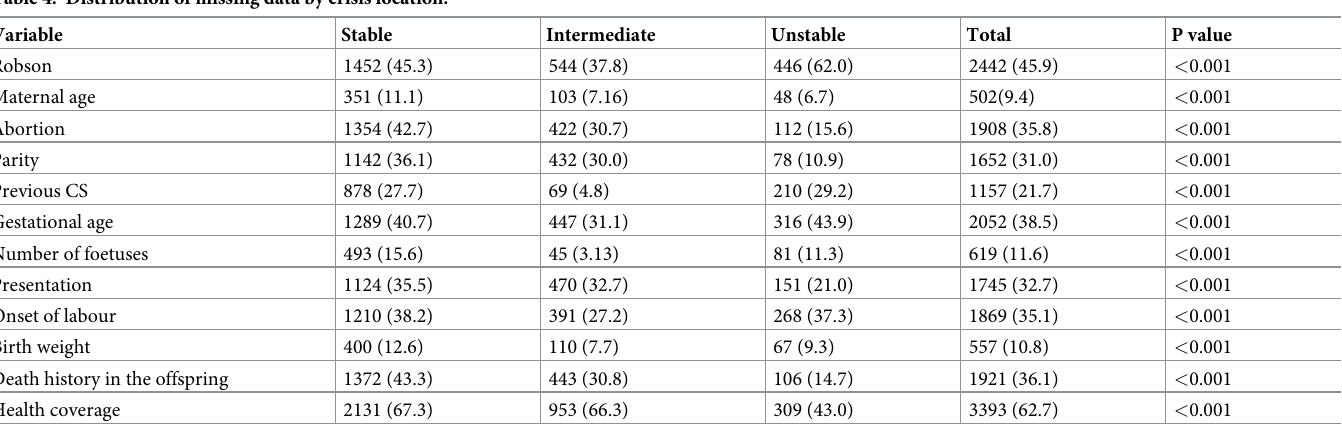
Table 4. Distribution of missing data by crisis